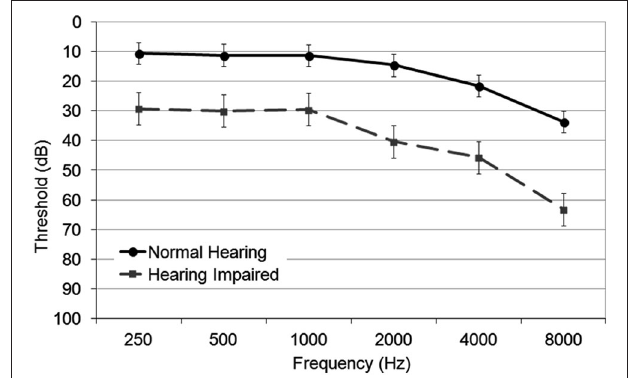
FIGURE 2 | Group mean likelyhood of reporting hearing two concurrent sounds as a function of mistuning and background noise. The error bars indicate ± 1 standard error of the mean. Normal hearing: darker gray bar; Hearing impaired: lighter gray